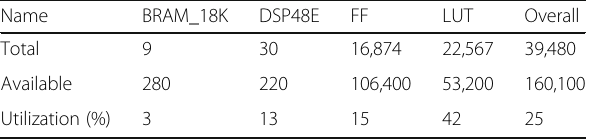
Table 5 First approach OCR algorithm utilization